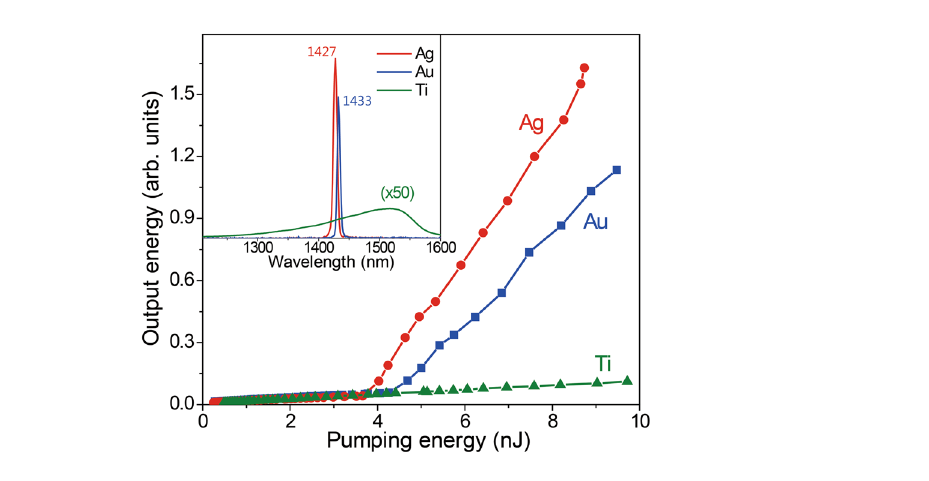
Figure 5. SP lasing from slits of different metals. Output versus pumping energy curves for metal gratings with Λ = 420 nm, made from different materials of Ag, Au, and Ti. The inset shows the emission spectra of the different metal slits at a pumping energy of 6